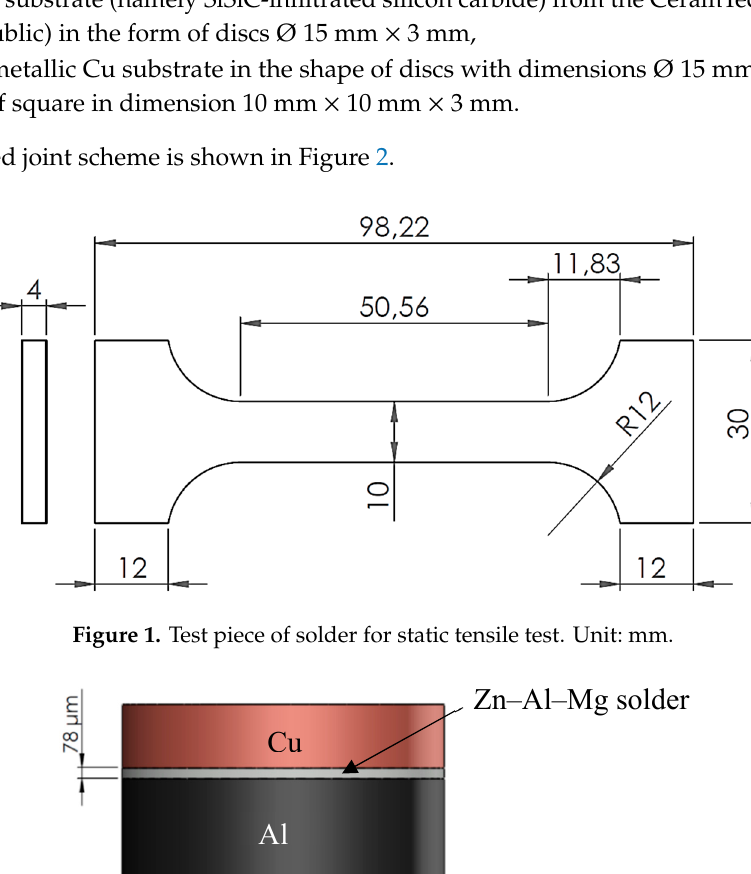
Figure 2. The fit-up of soldered joints.